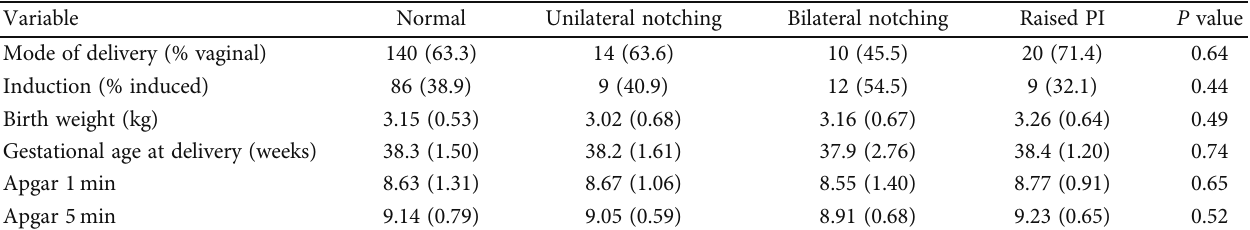
Table 3: Association of normal, unilateral notching, bilateral notching, and normal PI uterine artery Doppler with perinatal